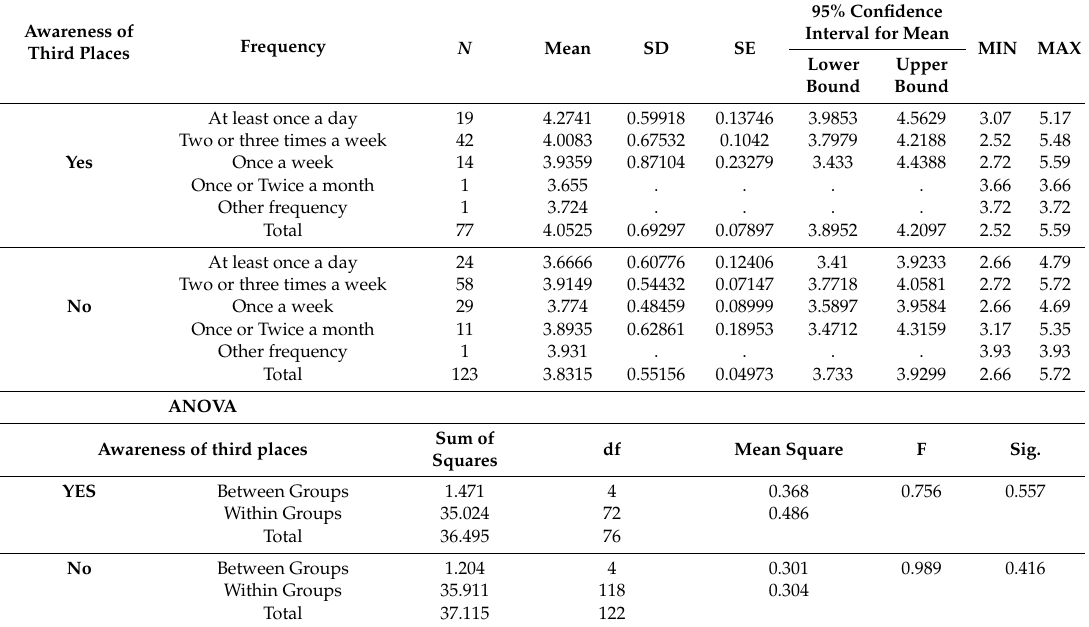
Table 3. ANOVA summary table for awareness of third places and frequency of visits with the mean of happiness.